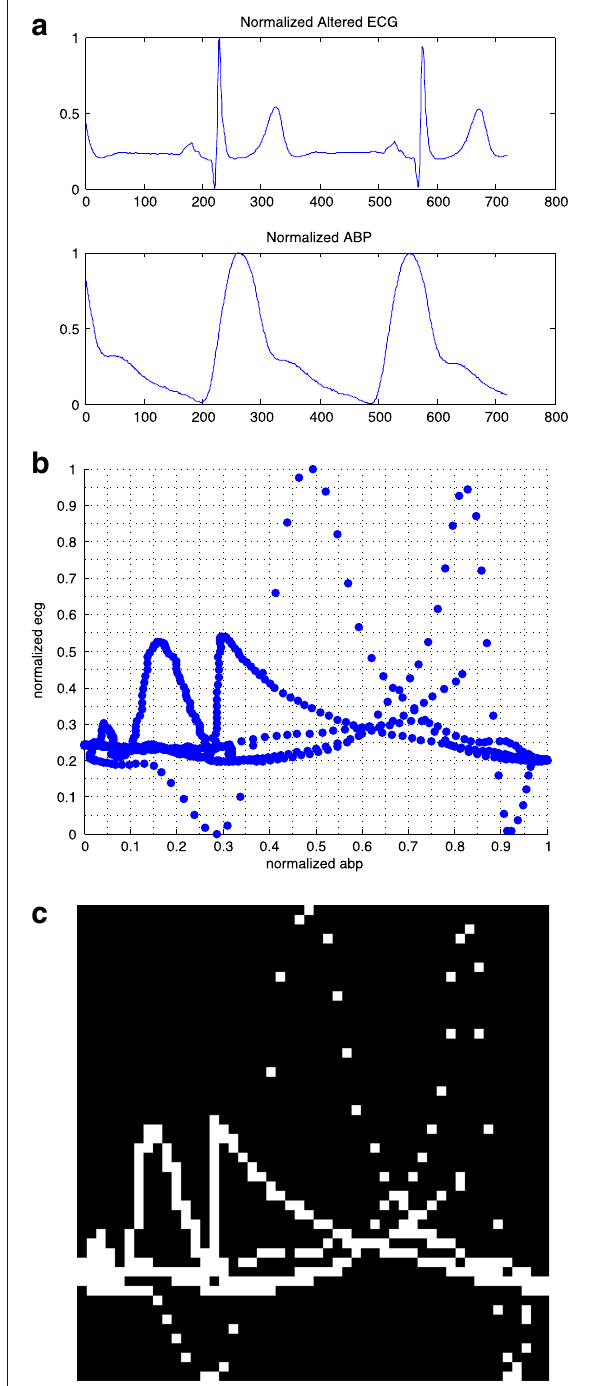
Fig. 9 A positive class image created by the same ABP snippet and an altered ECG measurement. The top one shows normalized altered ECG e (cid:3) ( t ) and normalized ABP a ( t ) . The middle one shows a portrait G (cid:3) generated based on e (cid:3) ( t ) and a ( t ) . The bottom one shows a positive class image I (cid:3)